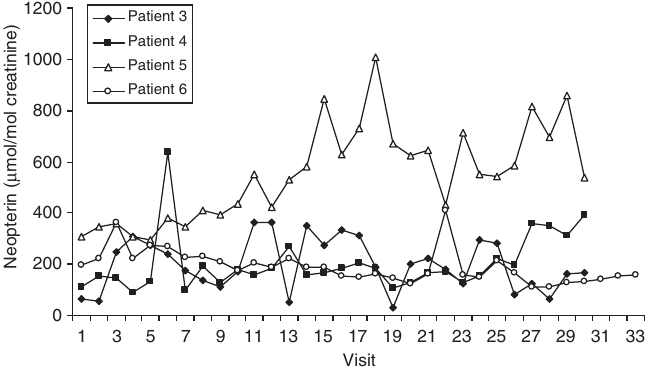
Figure 2 Urinary neopterin concentrations during the course of chemoradiation in patients 3–6, who had cervical carcinoma. The marked increase in urinary neopterin concentrations in patient 5 starting with visit 11 was associated with dyspeptic complaints accompanied by diarrhea and fatigue. Subsequently, the patient had skin rash. The peak urinary neopterin concentrations in patients 3 and 4 were accom- panied only by minor